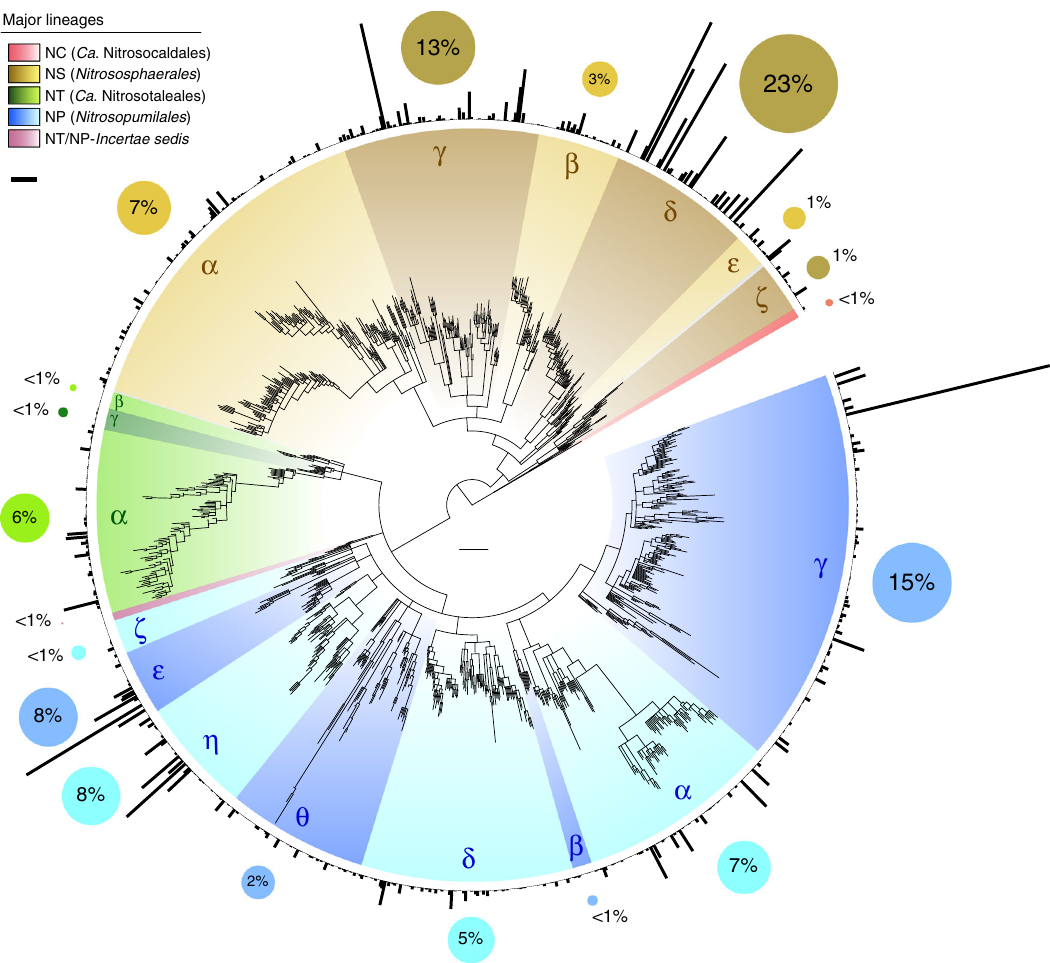
Fig. 4 Phylogenetic distribution of archaeal amoA gene frequency. OTU and clade frequencies are based on all sequences in the curated database, including identical sequences (33,378 sequences). Black bars represent total sequence counts per OTU (96% sequence identity) and are drawn in proportion to the highest value (1960 sequences); the scale bar (below the colour legend) represents 250 sequences. Coloured circles show the fraction of sequences in the database associated with each major clade and their diameter is relative to those fractions. The tree scale bar represents 0.1 substitutions per nucleotide position. Sequence frequencies in all clades and subclades are also available in an interactive Krona 47 chart (Supplementary Data 4). See legend of Fig. 1 for tree